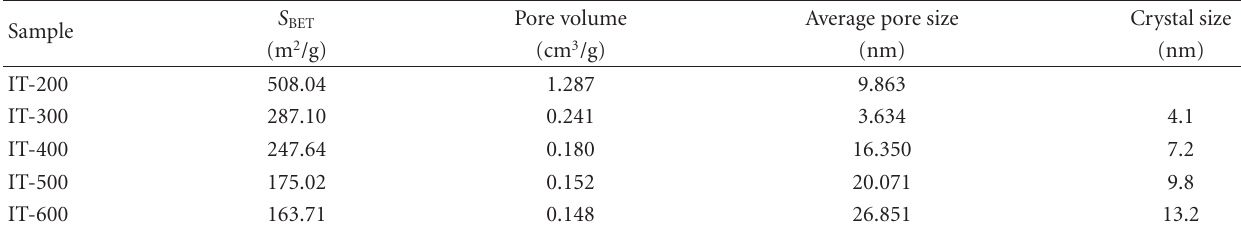
Table 1: Physicochemical properties of IT-T samples from N 2 sorption analysis and XRD results. a